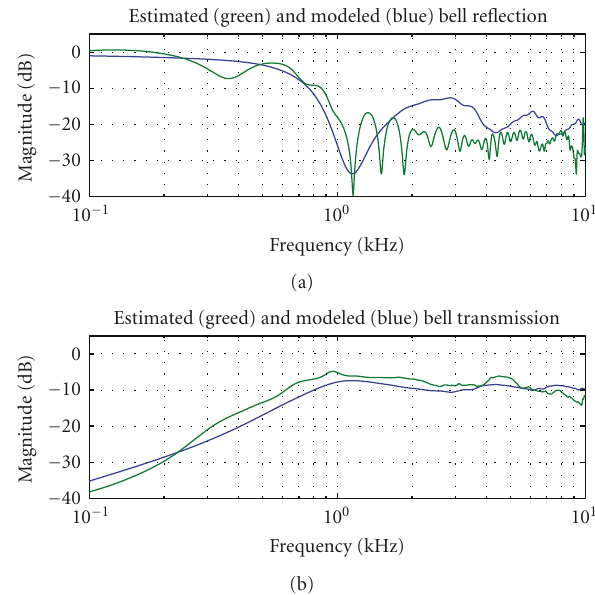
Figure 16: Estimated and modeled bell reflection (a) and transmis- sion (b) magnitudes.